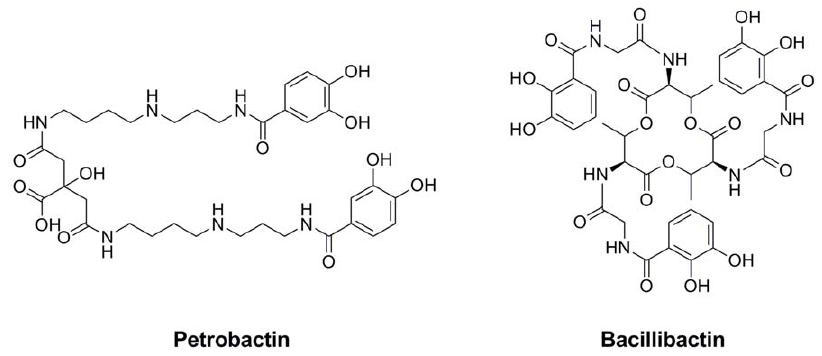
Figure 1. Chemical structures of B.anthracis siderophores petrobactin and bacillibactin.